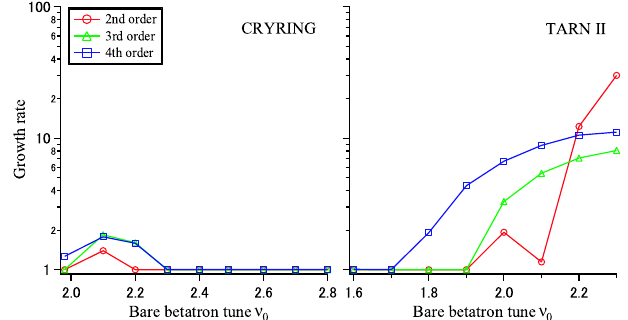
FIG. 9. (Color) Growth rates calculated by the linearized Vlasov analysis. The lattices of CRYRING and TARN II with the parameters in Table I were assumed. Resonance stop bands of three different orders are plotted as a function of (cid:2) dangerous resonance is that of the second